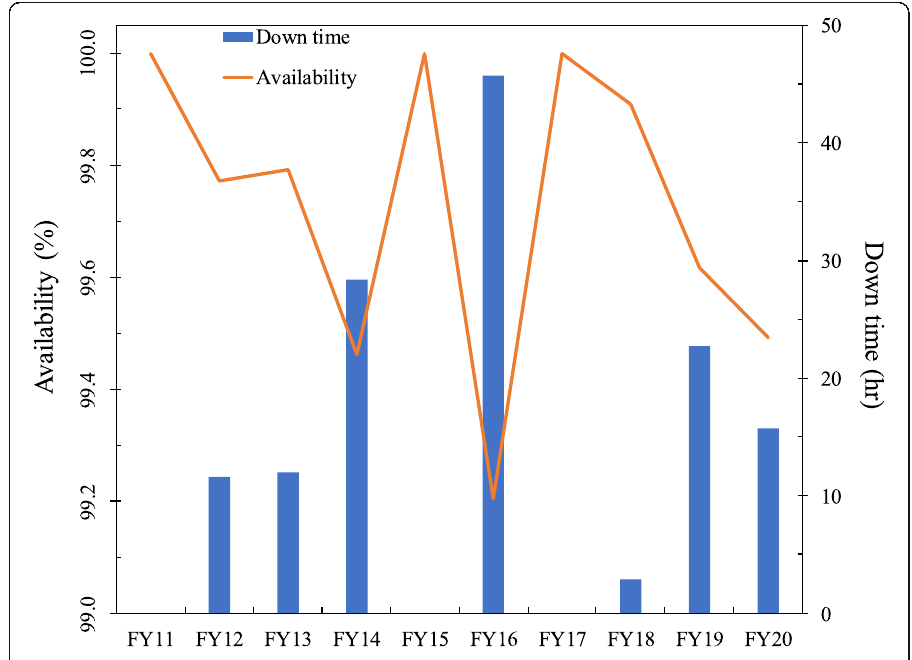
Fig. 4 Reliability data of the SNS Cryogenic system for last ten years of